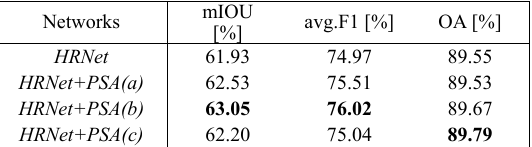
Table 1. Results of ablation experiments for the PSA generation on the RSIPAC dataset. Best scores are in bold font.